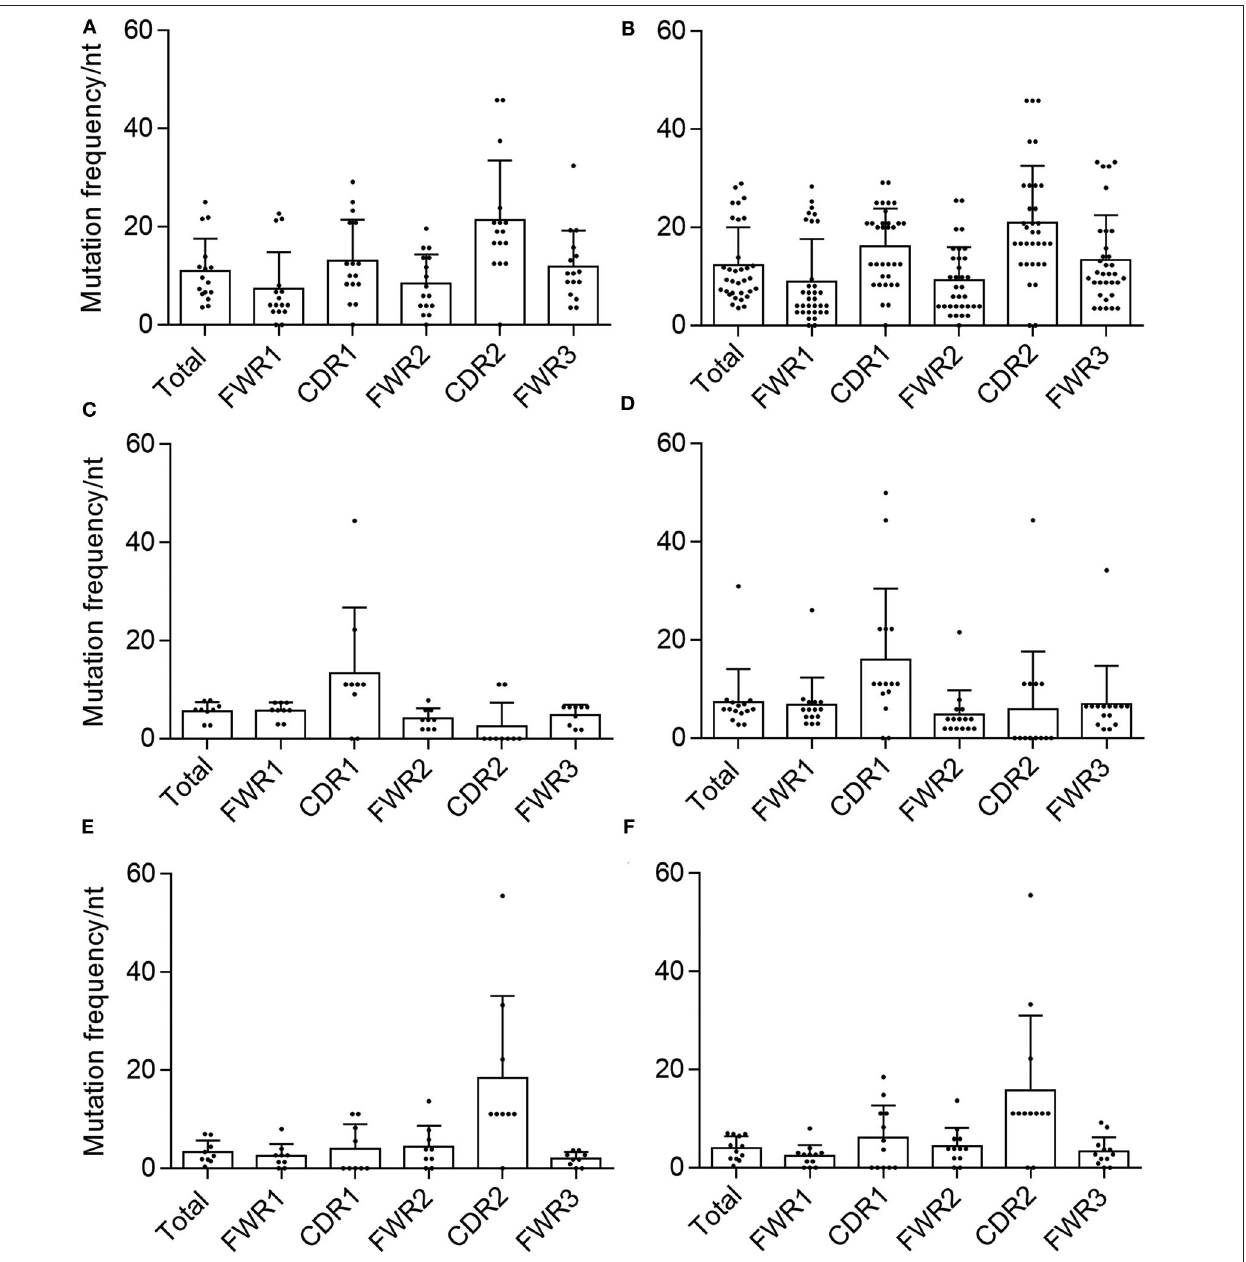
FIGURE 3 | Mutational frequency in AAV memory B cell-isolated variable chain sequences. We determined the frequency of nucleotide (nt) substitutions, defined as the percentage of positions containing a substitution, in the total isolated sequence (“total”), framework regions (“FWR1,” “FWR2,” “FWR3”), and complementarity determining regions (“CDR1,” “CDR2”) (as defined by IMGT). Frequencies were determined for validated (A) variable heavy, (C) variable kappa, and (E) variable lambda sequences as well as all isolated (B) variable heavy, (D) variable kappa, and (F) variable lambda sequences. Data are displayed as mean ±